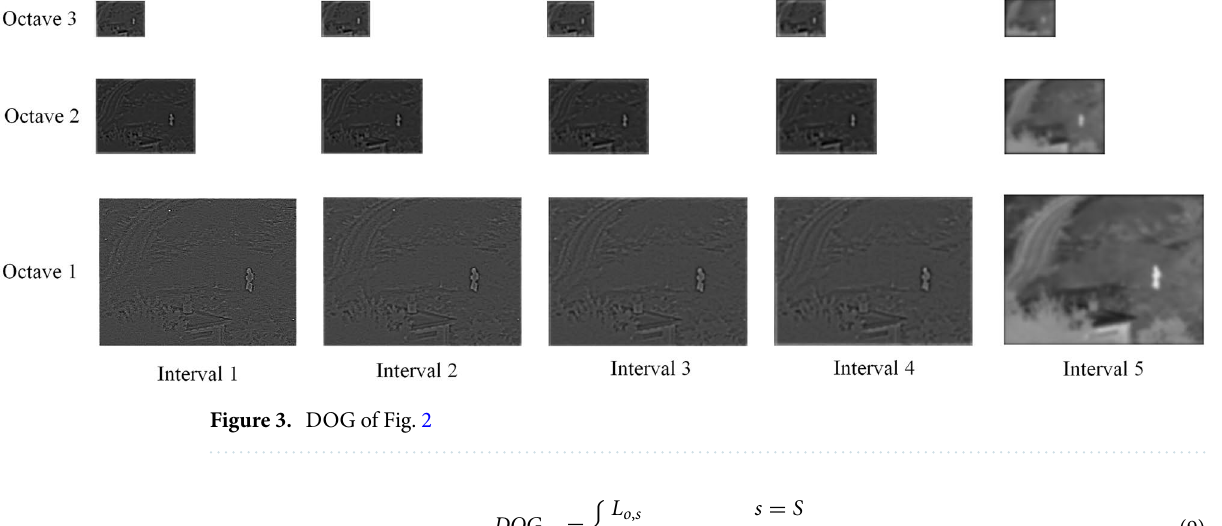
Figure 3. DOG of Fig.